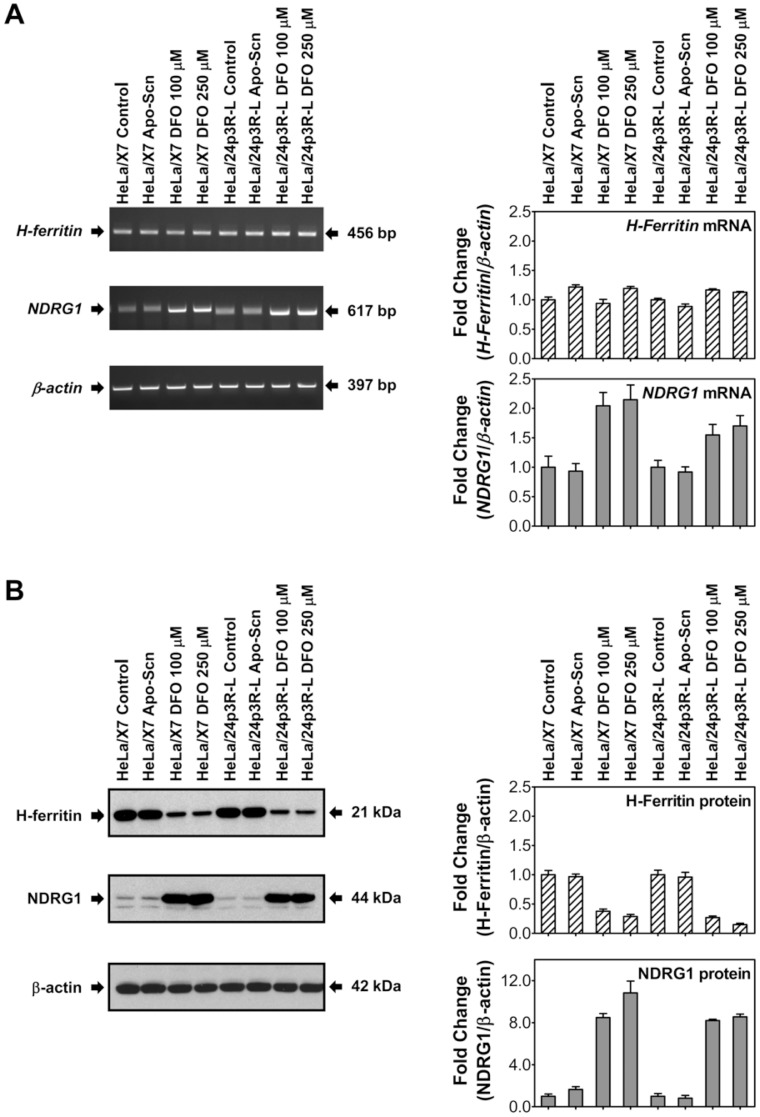
Added Scn does not affect the expression of iron responsive genes.Expression of H-ferritin (FTH-1) and NDRG1 in HeLa/X7 and HeLa/24p3R-L cells was assayed by RT-PCR (A) and Western blot (B). Cells were untreated or treated with 2 µM murine Scn or DFO (100 µM or 250 µM) for 24 h. Densitometry results (right) were calculated relative to β-actin; error was calculated from the standard deviation among three experiments; a typical result from three experiments is shown in (A) and (B).